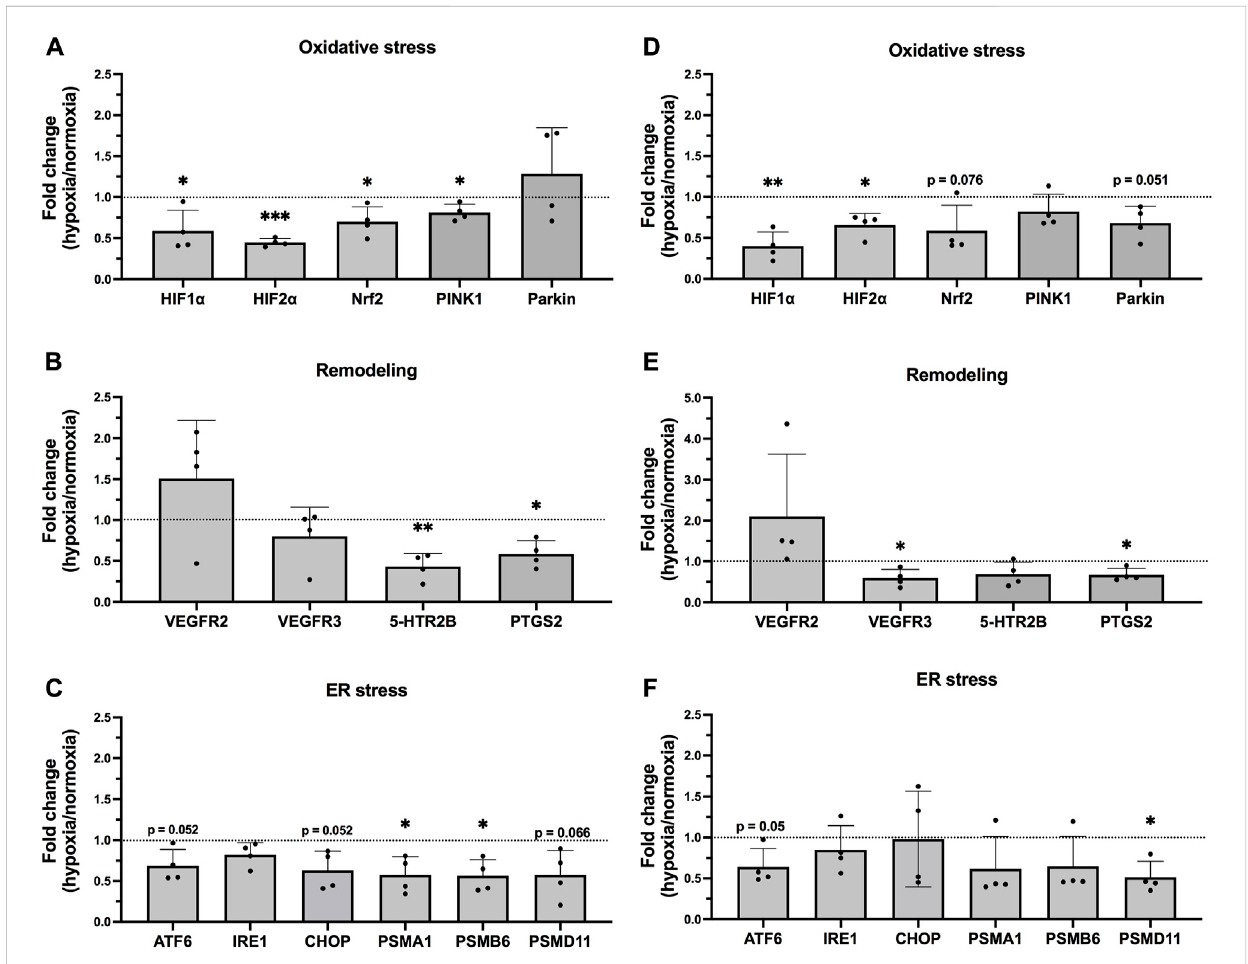
FIGURE 1 mRNA levels in epithelial cells exposed to hypoxia. Hypoxia-target genes in BEAS-2B (A – C) and hAELVi (D – F) . Data is based on four individual experiments ( n = 4). The data is presented as the ratio of hypoxia and normoxia with mean ± SD. Black dotted line ratio = 1. Statistical analysis was performed using qPCR data was analysed with One sample t -test. * p < 0.05, ** p < 0.01, *** p < 0.001, **** p <